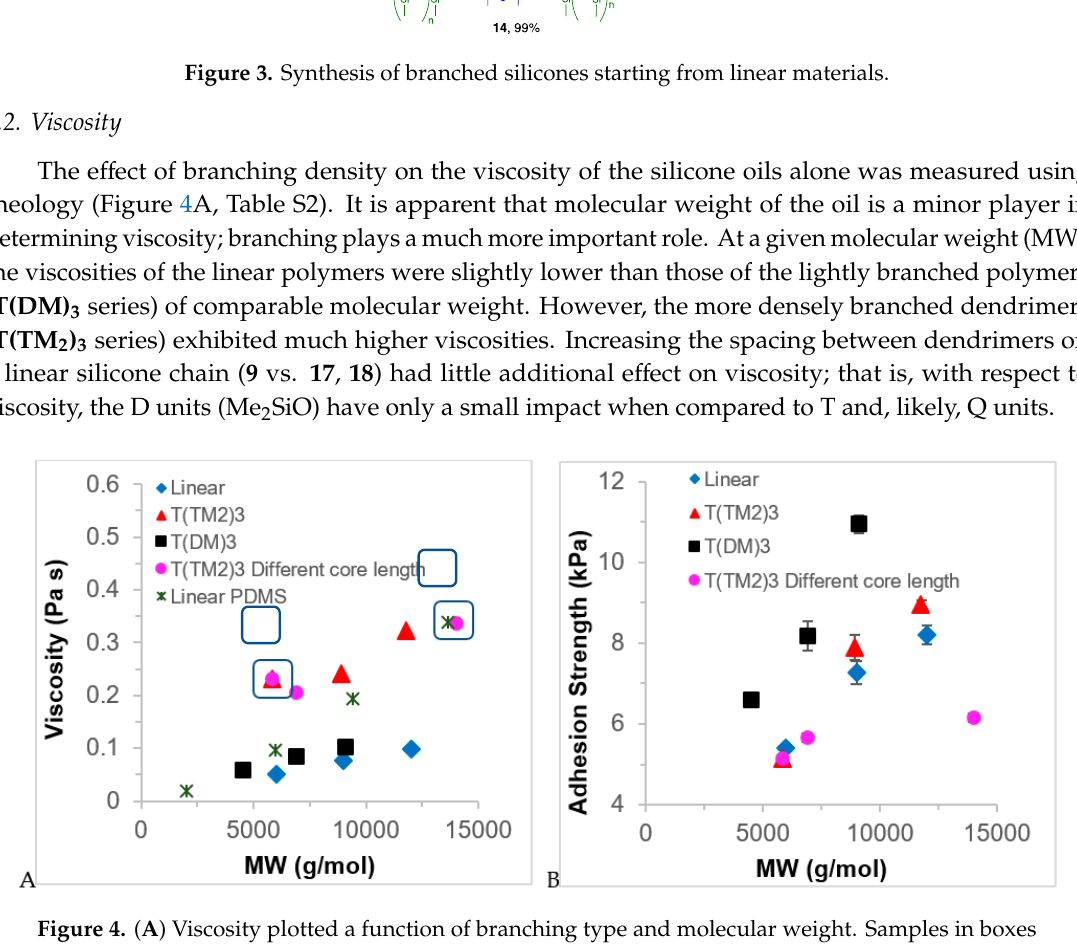
Figure 4. ( A ) Viscosity plotted a function of branching type and molecular weight. Samples in boxes have the same fraction of M groups. ( B ) The influence of MW on the adhesion work of oil filled elastomers with 25 wt% loading. Note the small change in viscosity between the 2-fold hyperbranched polymer ▲ 9 M n = 5860 g mol − 1 and the analogue with a ~8000 g mol − 1 spacer between the same dendrons ● 18 14,000 g mol − 1 . The error bars represent the standard deviation of 3 measurements but were so small that they fall underneath the marker (the data may be found in Table S2).